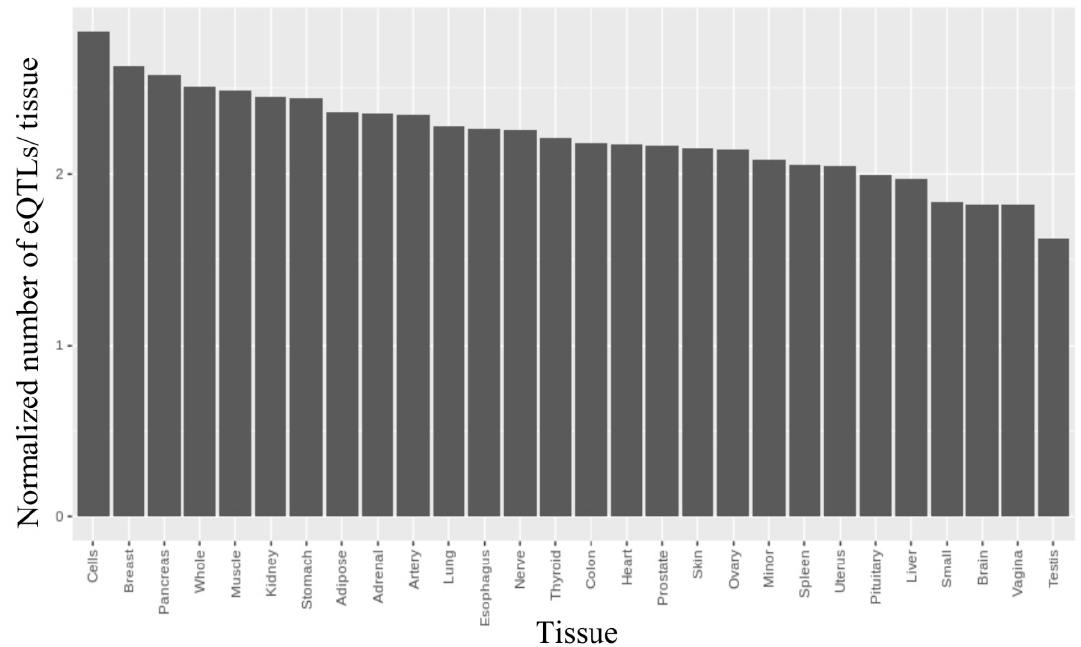
Figure 5. Normalized tissue distribution of the rSNPs mapped as GTExeQTLs.The ordinate shows the number of eQTLs (padj < 0.1) identified for all rSNPs in the tissue normalized on the number of all GTExeQTLs mapped in the tissue with padj < 0.1; the abscissa shows the tissue source with grouping by type.